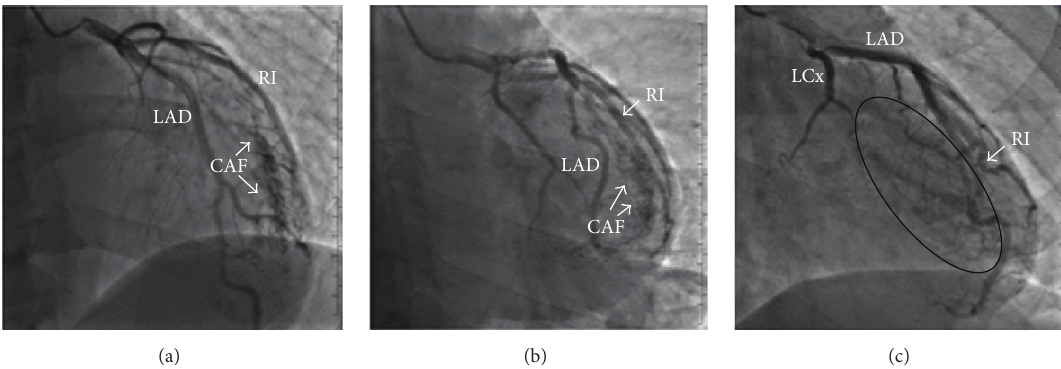
Figure 1: (a, b) Coronary arteriography demonstrating coronary artery fistulas (CAFs) arising from the ramus intermedius (RI) coronary artery and emptying into the left ventricle (LV). (c) The black circle shows filling of the LV chamber from the CAFs that arise from the RI seen during coronary arteriography. Left anterior descending (LAD) artery; left circumflex (LCx)